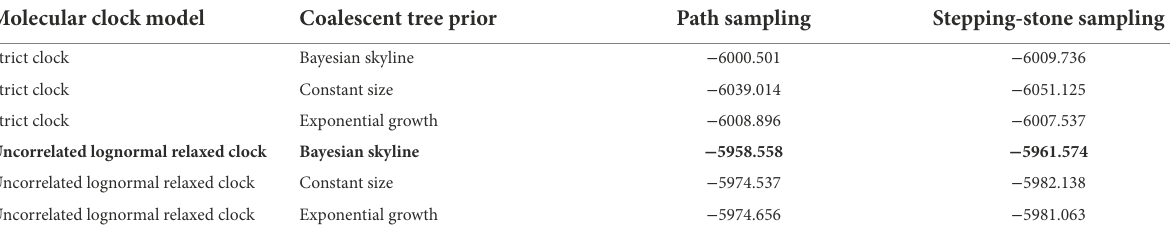
TABLE 1 Log marginal likelihoods of different combinations of the clock model and tree